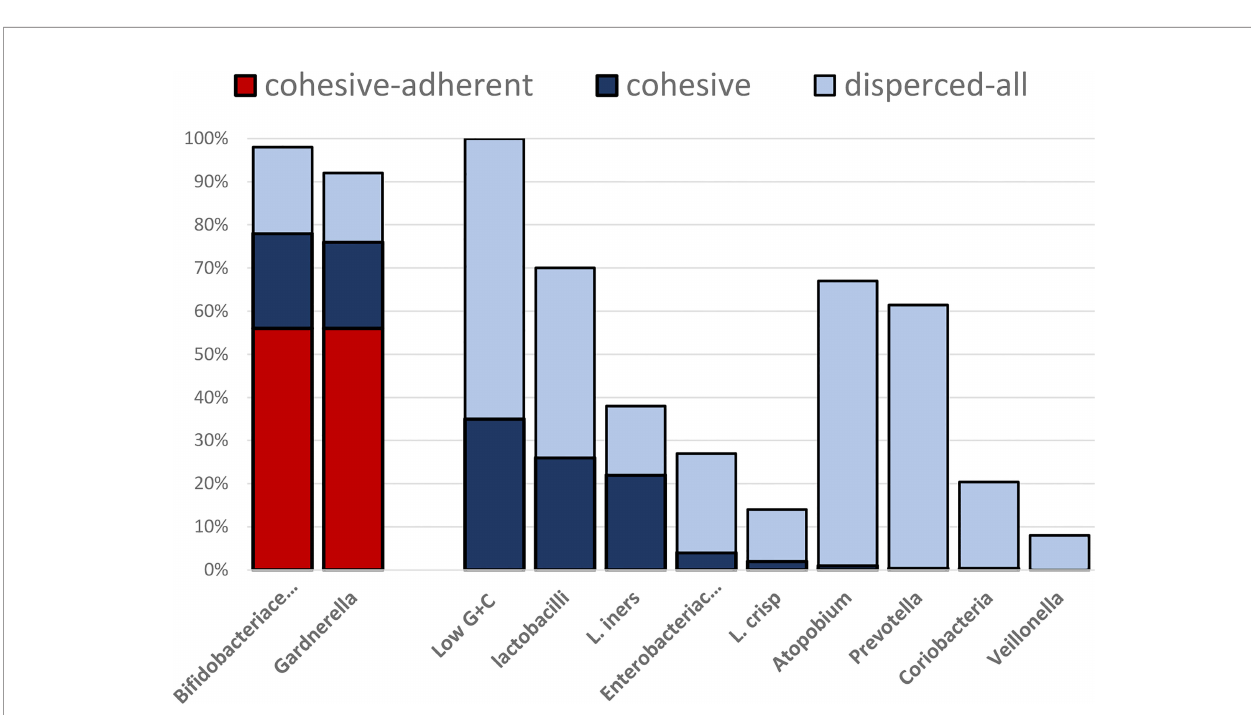
GRAPH 1 | Percent of samples demonstrating cohesive adherent, cohesive non-adherent, and dispersed patterns of spatial distribution for each of the investigated microbial groups. The exact numbers are presented in Table 1 (as additional material